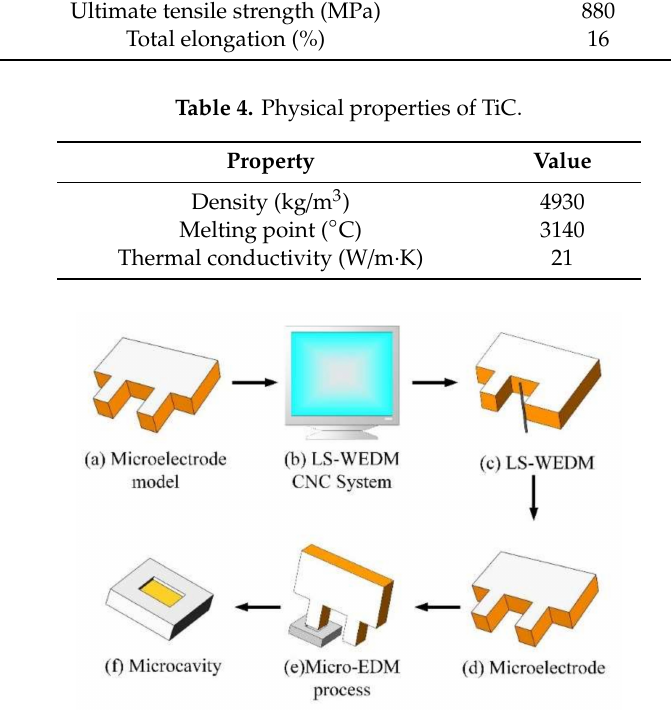
Figure 4. Fabrication process of microelectrode and